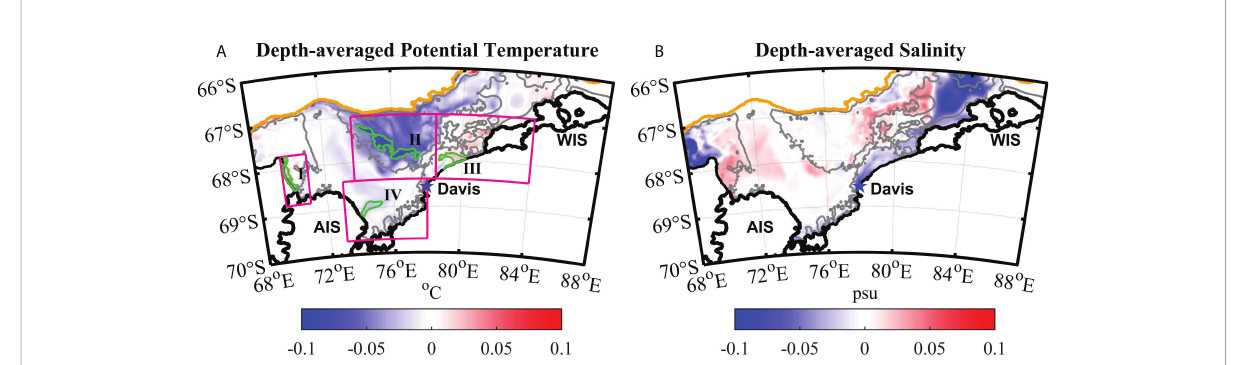
FIGURE 4 (A) The differences of the depth-averaged potential temperature (°C) between Result A and Result B (B minus A). The green wireframes indicate the locations where the potential temperature changes are the greatest within the speci fi ed regions (I, II, III, and IV) bounded by the pink boxes. The grey line and the orange line represent the 500 m and 1000 m isobaths from the CB, respectively. (B) Same as (A) , but for the salinity